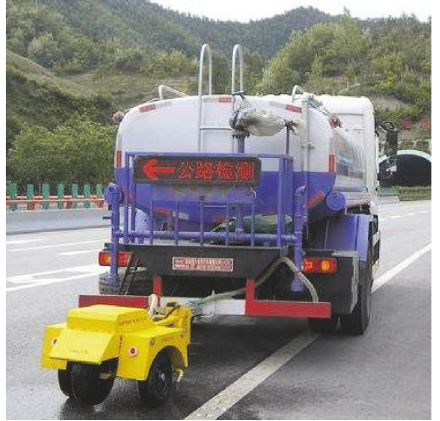
Figure 6: Detection vehicle of transverse force coefficient measure- ment.